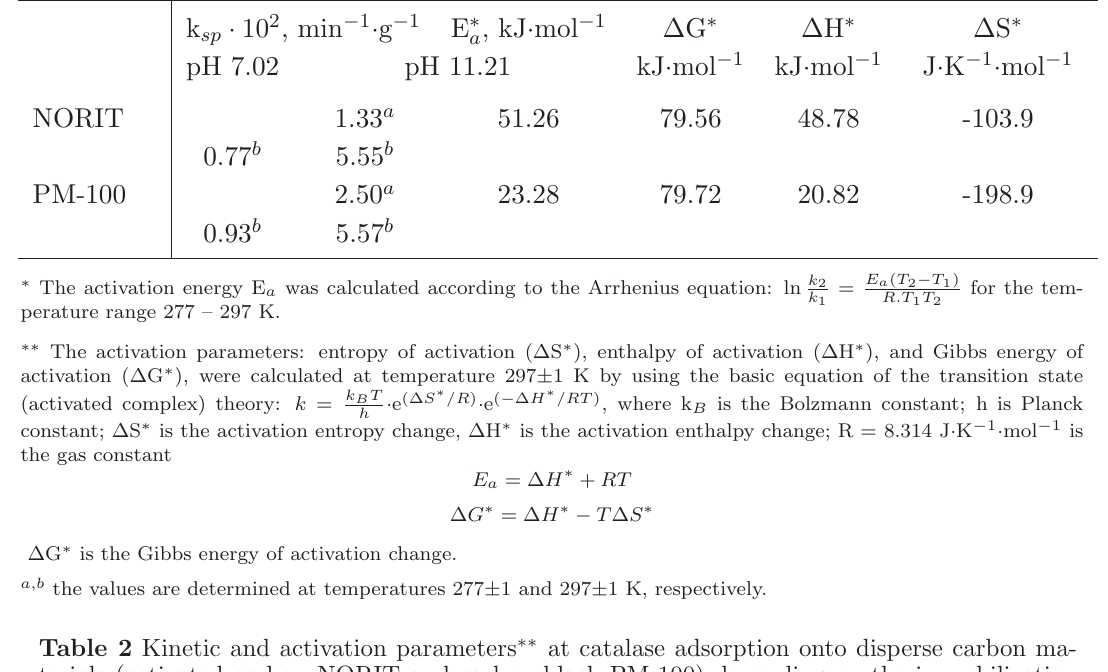
Table 2 Kinetic and activation parameters ∗∗ at catalase adsorption onto disperse carbon ma- terials (activated carbon NORIT and carbon black PM-100) depending on the immobilization matrix, the pH of the enzyme solution and the temperature of